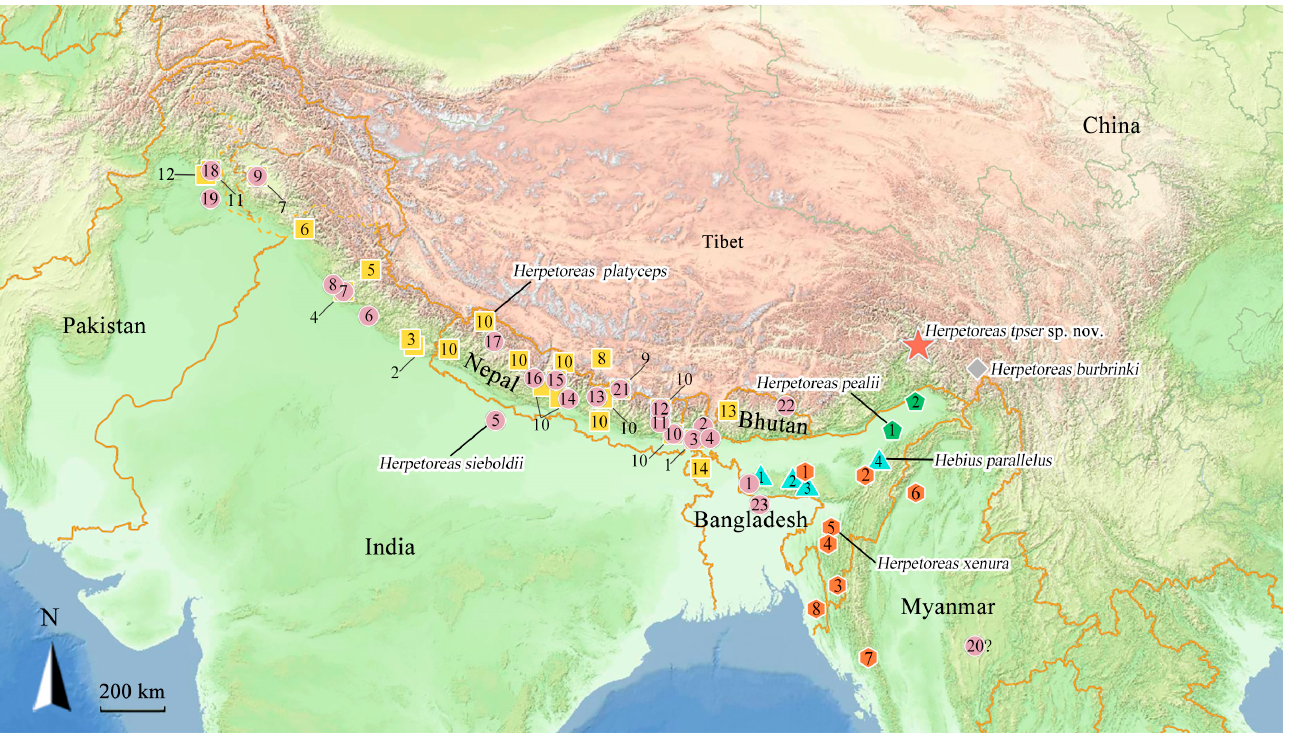
Figure 2. General distribution map of members of Herpetoreas and Hebius parallelus , star represents the type locality of Herpetoreas tpser sp. nov. from Mêdog County, Xizang Autonomous Region (Tibet), China; rhombus represents the locality of Her. burbrinki ; pentagon: Her. pealii ; hexagon: Her. xenura ; square: Her. platyceps ; circle: Her. sieboldii ; triangle: Heb. parallelus . Detailed information of numbers of the localities were listed in Appendix B.